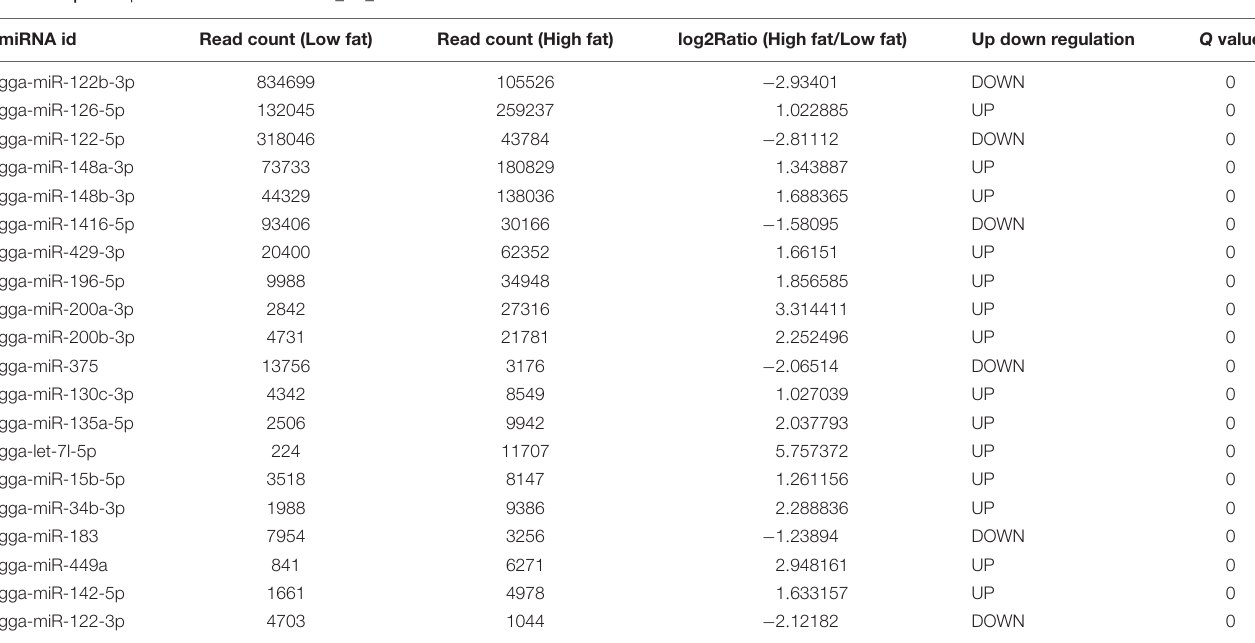
FIGURE 2 | Differentially expressed miRNA in abdominal fat between low fat broilers and high fat broilers. (A) Volcano plot for low-fat_VS_high-fat DEMs. (B) The known and novel miRNAs (down-regulated or up-regulated) from DEMs. TABLE 4 | The top 20 abundant DEMs in